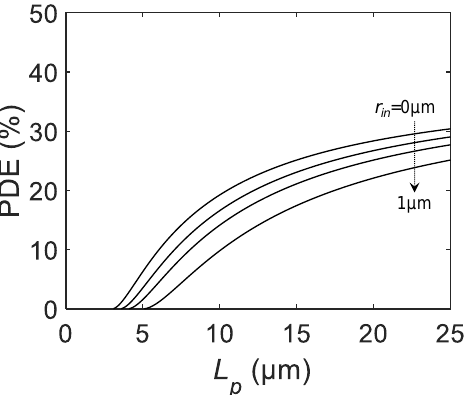
Figure 4. The calculated PDE as a function of the SPAD pixel pitch L p for PDP max = 50%, active-to- active distance L a − a = 3 µ m, and inactive radius r in = 0, 0.25, 0.5, and 1 µ